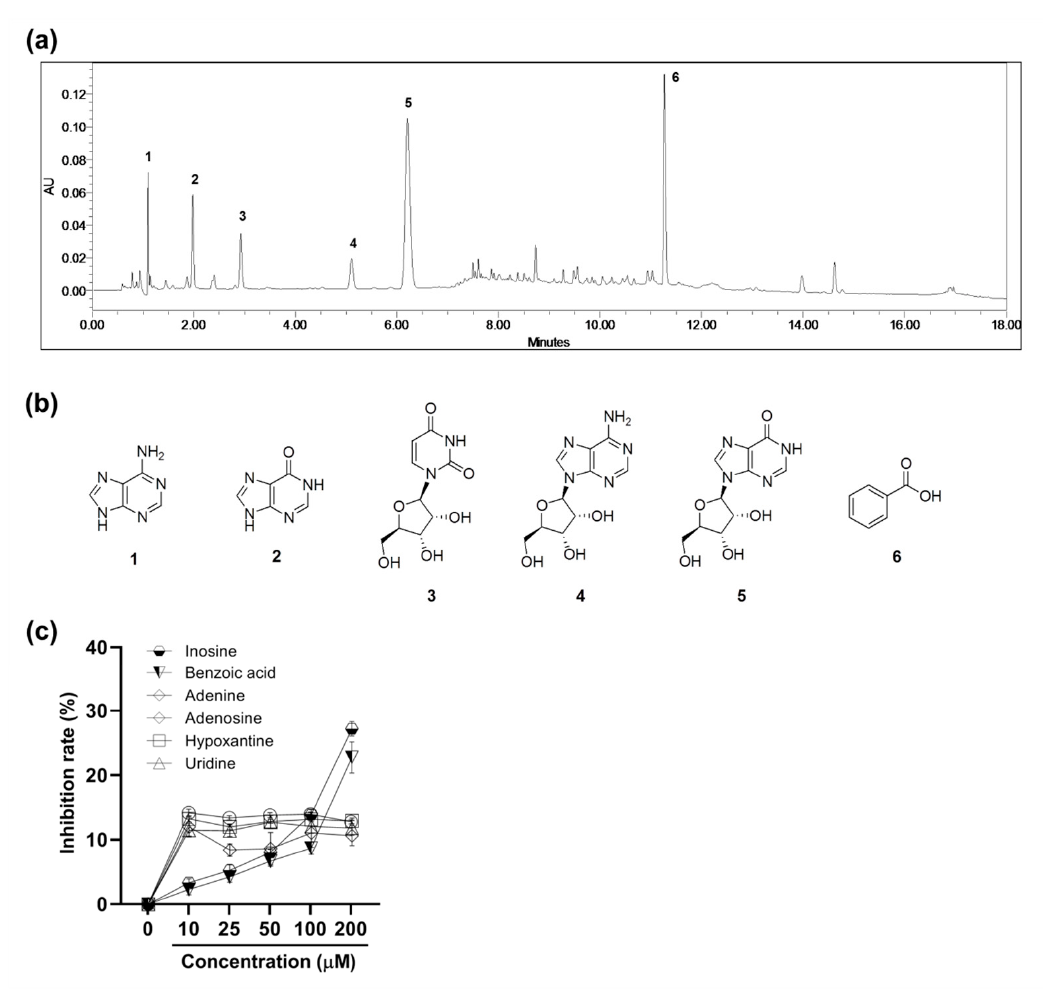
Figure 6. The ultra-performance liquid chromatography (UPLC) chemical profile of the Protaetia brevitarsis seulensis’ water extract and antioxidative activity of isolated compounds. ( a ) UPLC chromatogram of the extract with detection at ultra-violet 254 nm. ( b ) Chemical structures of compounds including adenine ( 1 ), hypoxanthine ( 2 ), uridine ( 3 ), adenosine ( 4 ), inosine ( 5 ), and benzoic acid ( 6 ). ( c ) The free radical scavenging activity of the isolated six compounds in the 2,2-diphenyl-1-picryl- hydrazyl-hydrate assay. Values are reported as mean ±